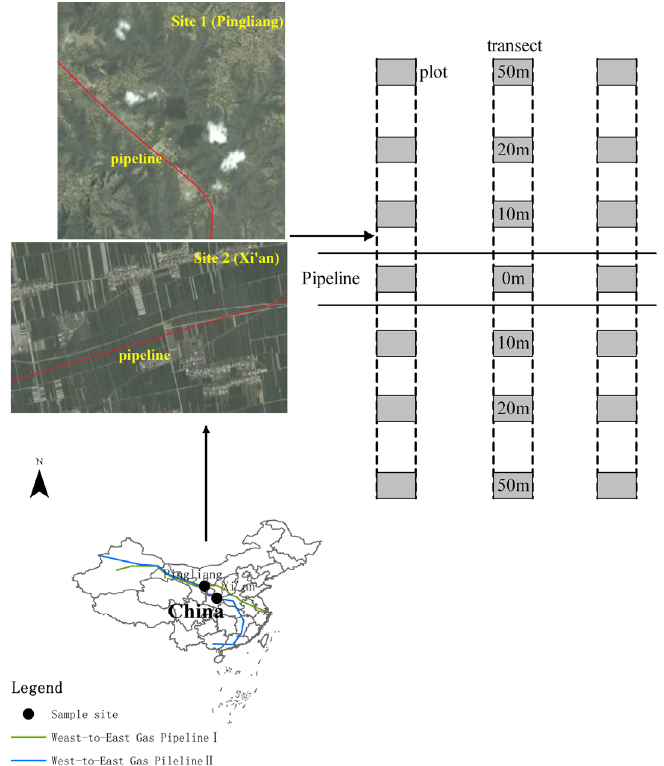
Figure 1. The two sample sites Site 1 (Pingliang) and Site 2 (Xi’an) along nature gas pipelines right-of-way and sample plots that were set up at seven different distances from the